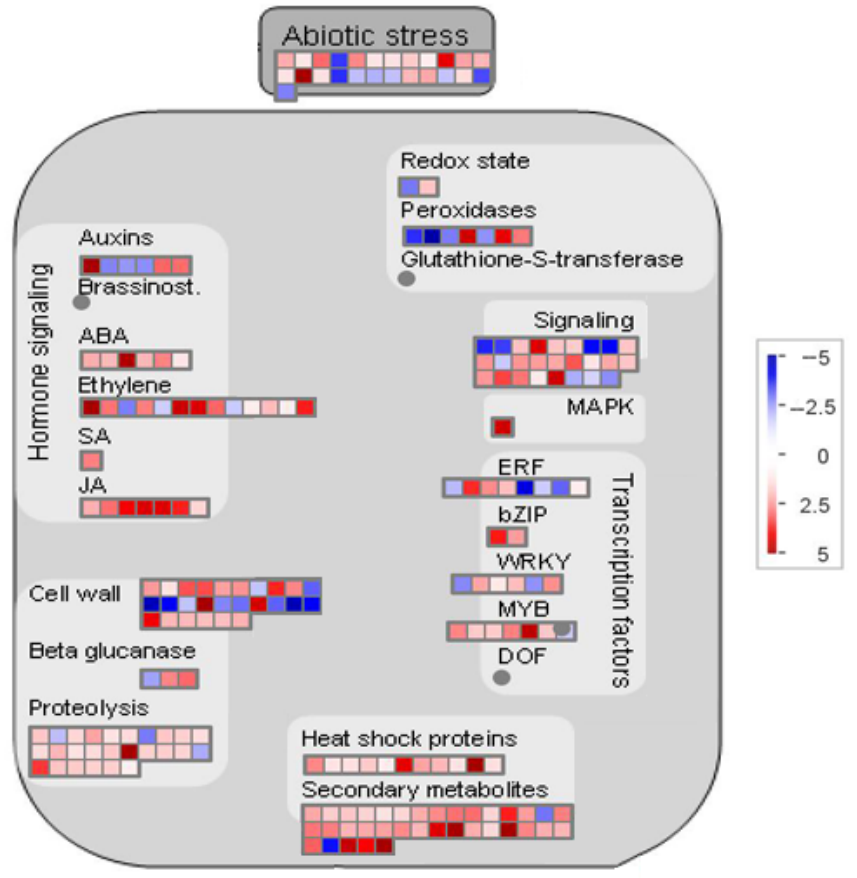
Figure 5. Overview of the abiotic stress pathway of genes responsive to alkali stress treatments in M. cerifera . Brassinosteroid (brassinost., BR), mitogen-activated protein kinase (MAPK), jasmonic acid (JA), salicylic acid (SA), ethylene response factor (ERF), basic leucine zipper (bZIP), MYB domain transcription factor (MYB), WRKY domain transcription factor (WRKY), Dof-type zinc finger domain-containing protein (DOF).